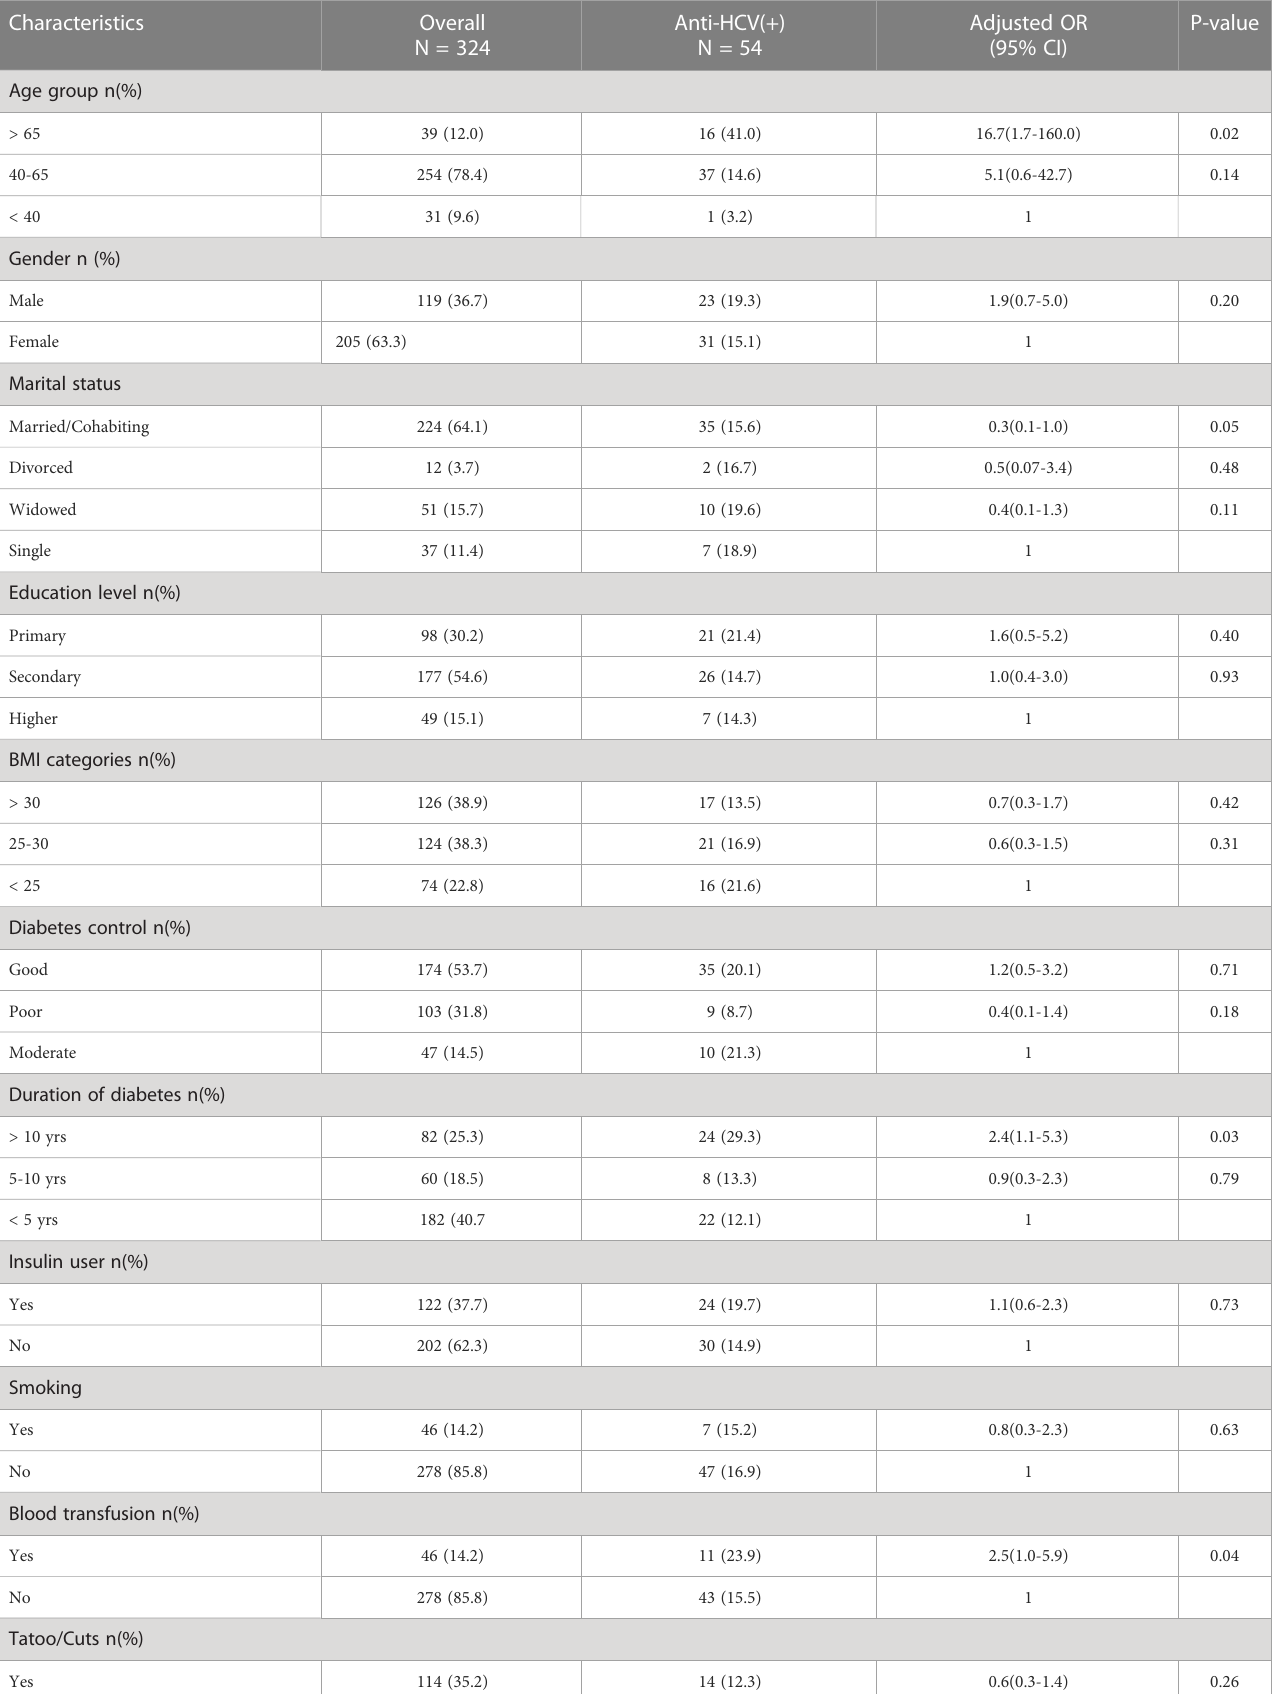
TABLE 4 Logistic regression examing the determining factors for the HCV infection and type 2 diabetes